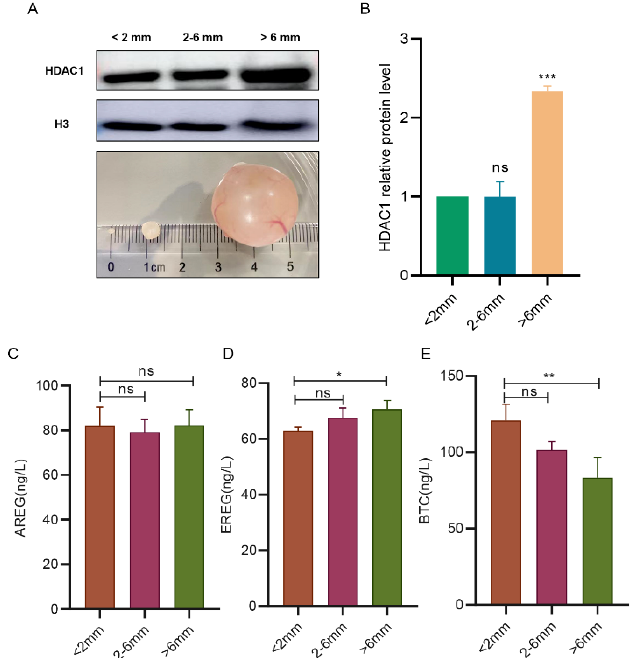
Figure 2. The expression level of HDAC1 and the secretion levels of EGF-like growth factors, including AREG, EREG and BTC, in the follicles at different developmental stages. ( A , B ): The expression levels of the HDAC1 protein in the follicles were analyzed by Western blotting. Stripped follicles, from left to right: small antral follicle (diameter, <2 mm), medium antral follicle (diameter, 2 - 6 mm) and large antral follicle (diameter, >6 mm). ( C-E ): The levels of AREG, EREG and BTC in the follicles at different developmental stages were examined through ELISA. * p < 0.05; ** p < 0.01; *** p < 0.001; ns: Indicate no significant differences, n = 3.